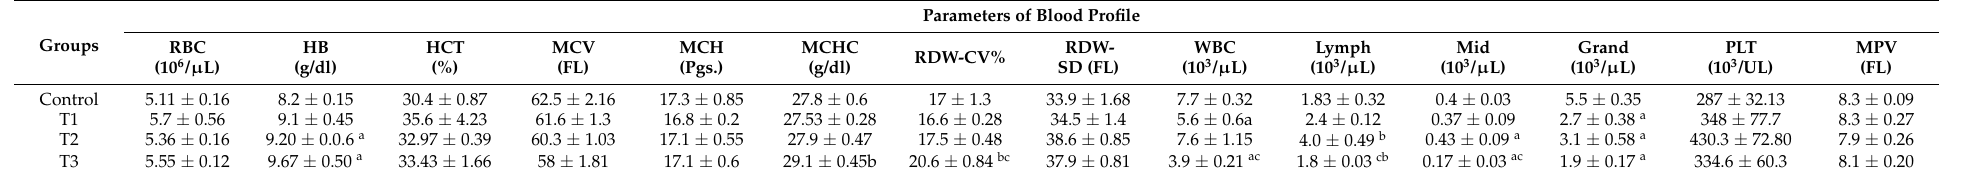
Table 4. Effect of pomegranate peel and garlic powder separately or in combination on blood profile of rabbit’s kits after 4 weeks.